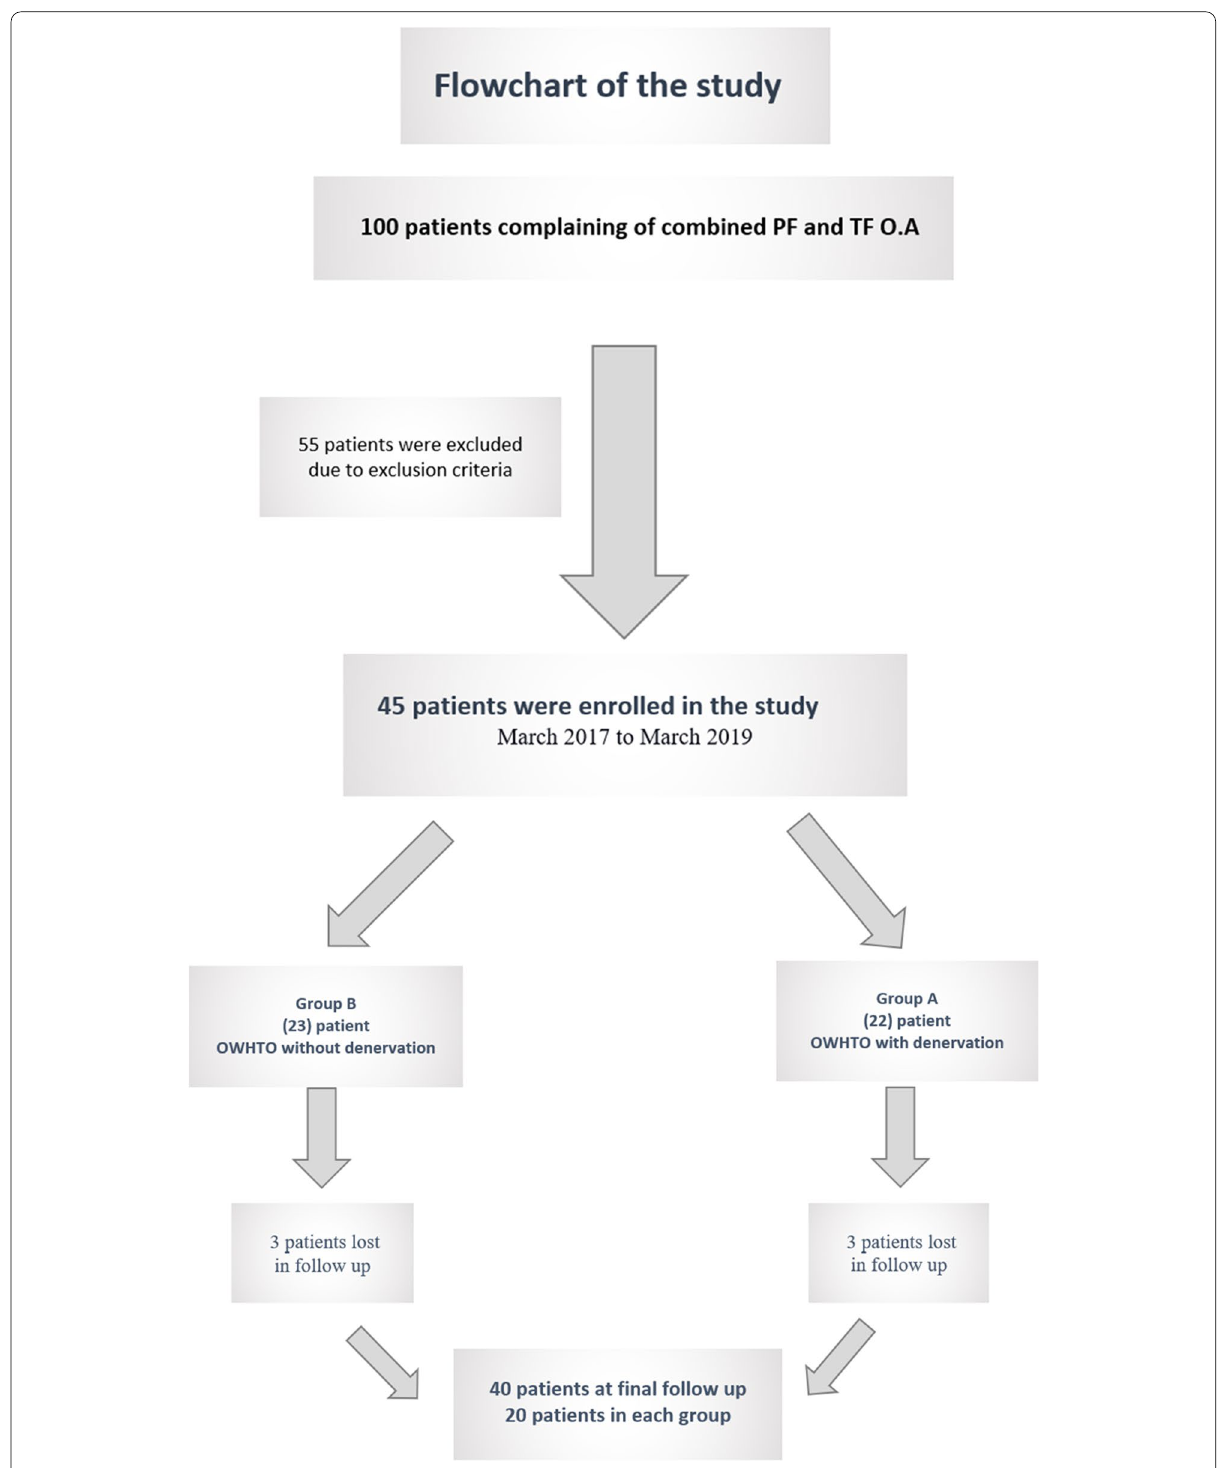
Fig. 1 Patient flow